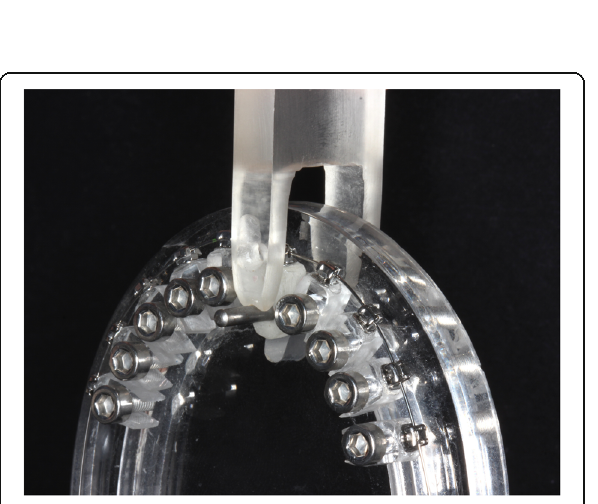
Fig. 2 Tip of the universal testing machine moving bucco-palatally the acrylic block